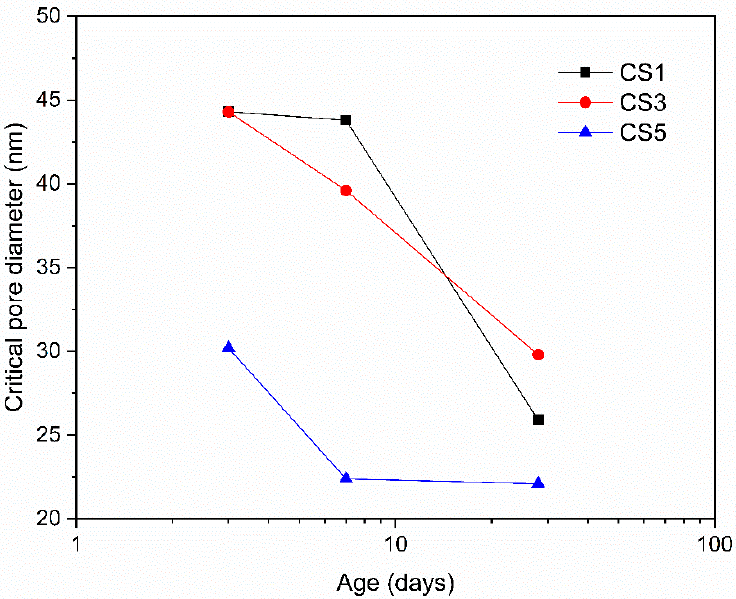
Figure 15. Critical pore size of hydrated slag pastes determined by nitrogen adsorption at 3, 7 and 28 days.